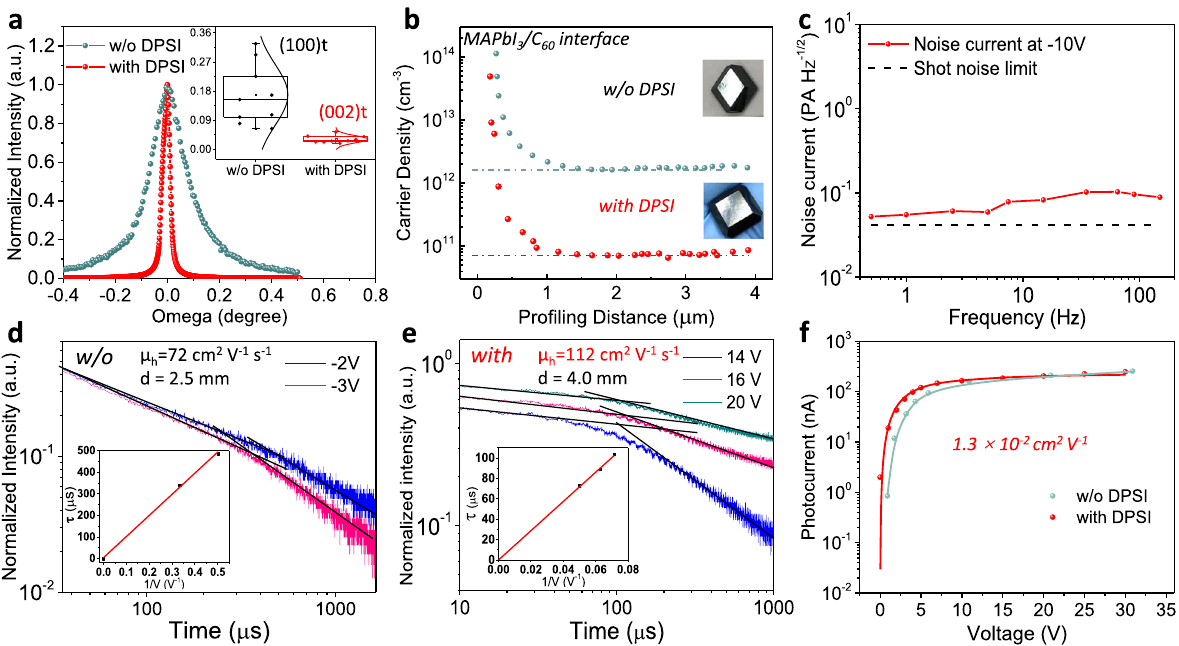
Fig. 3 Material and electronic characterization of MAPbI 3 crystals. a X-ray rocking curves for MAPbI 3 single crystals grown w/o and with DPSI, and the statistical FWHM results are shown as the insert. b Trap density pro fi led by DLCP for the crystals at different pro fi ling distance from top surface. c Noise current of the crystal grown with DPSI. d , e Time of fl ight transient currents of the crystals grown w/o and with DPSI. f Photoconductivity comparison of the crystal w/o and with DPSI under weak ambient light intensity of 1 × 10 − 4 W cm − 2